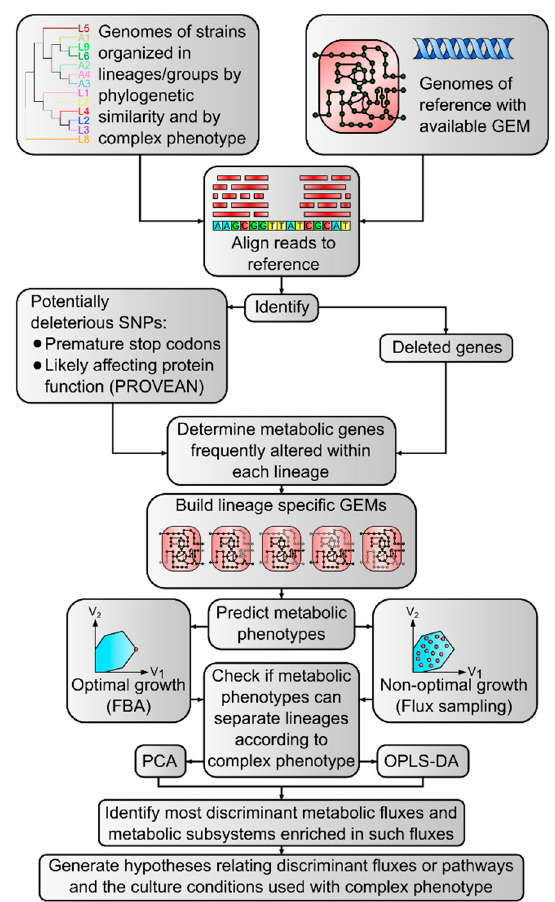
Figure 7. Workflow used in the analysis. We started with genomic sequences of Mycobacterium tuberculosis that aggregate in lineages and exhibit a complex phenotype (host association), and a reference sequence with a genome-scale metabolic model (GEM) available. Short reads mapping to reference served to identify deletions and potentially deleterious SNPs. We identified which of them were prevalent within each lineage and adapted the reference GEM to build lineage-specific versions. The resulting models were used to predict metabolic phenotypes, to later check if they can be used to separate lineages according to the complex phenotype (host association in our case). By identifying the most discriminant fluxes and the enriched subsystems in these fluxes, we can generate hypotheses relating the discriminant fluxes and the complex phenotype.